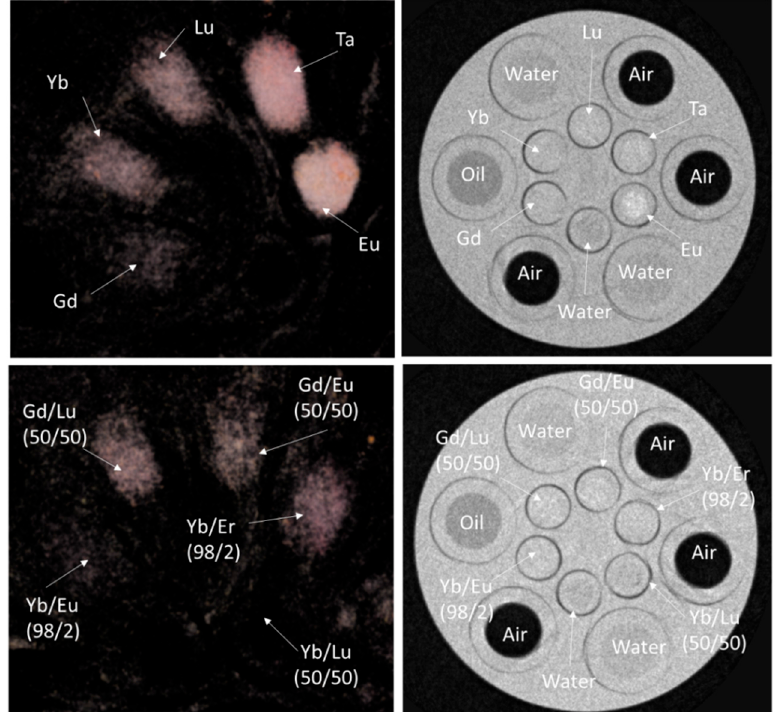
Figure 3. Micro-CT images of different PAA-stabilized NPhs at 90 mg/mL in water. The contrast shown in the images is derived from bin 1 and is only indicative of the water dispersibility of the samples (not the attenuation). The attenuation coefficient of those samples was measured from bins 4 or 5. Higher color strength represents attenuation coefficient intensity.